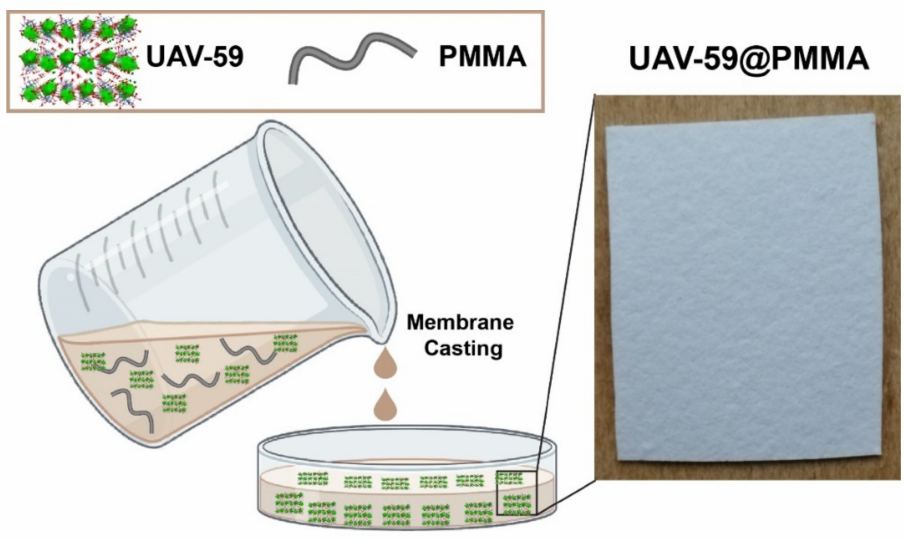
Figure 1. Schematic representation for the preparation of a membrane and a photograph of the UAV-59@PMMA membrane used in the current